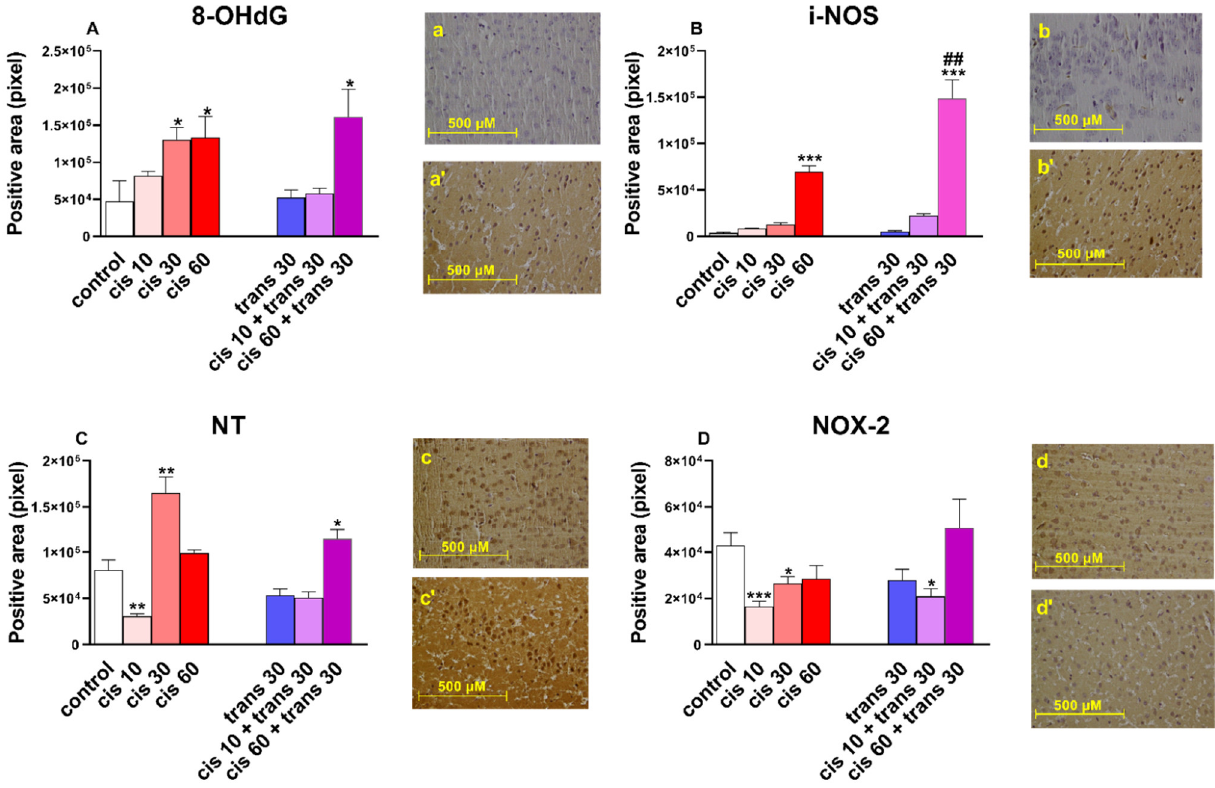
Figure 3. ( A ) Quantification and comparison of 8-OHdG positive areas in controls versus 4-4′-DMAR-mice ((±) cis 10, (±) cis 30, (±) cis 60, (±) trans 30, (±) trans 30 + (±) cis 10, (±) trans 30 + (±) cis 60). Representative image (light microscopy, 40×) of 8-OHdG immunostaining (brown areas) in the cortex of mice receiving 4-4′-DMAR ((±) cis 30, a’) and controls (a). ( B ) Quantification and comparison of iNOS positive areas in controls versus 4-4′-DMAR-mice ((±) cis 10, (±) cis 30, (±) cis 60, (±) trans 30, (±) trans 30 + (±) cis 10, (±) trans 30 + (±) cis 60). Comparison of (±) cis 60 versus (±) trans 30 + (±) cis 60. Representative image (light microscopy, 40×) of iNOS immunostaining (brown areas) in the cortex of mice receiving 4-4′-DMAR ((±) cis 60, b’) and controls (b). ( C ) Quantification and comparison of NT (nitrotyrosine) positive areas in controls versus 4-4′-DMAR-mice ((±) cis 10, (±) cis 30, (±) cis 60, (±) trans 30, (±) trans 30 + (±) cis 10, (±) trans 30 + (±) cis 60). Representative image (light microscopy, 40x) of NT immunostaining (brown areas) in the cortex of mice receiving 4-4′-DMAR ((±) cis 30, c’) and controls (c). ( D ) Quantification and comparison of NOX2 positive areas in controls versus 4-4′-DMAR-mice ((±) cis 10, (±) cis 30, (±) cis 60, (±) trans 30, (±) trans 30 + (±) cis 10, (±) trans 30 + (±) cis 60). Representative image (light microscopy, 40×) of NOX2 immunostaining (brown areas) in the cortex of mice receiving 4-4′-DMAR ((±) cis 30, d’) and controls (d). * p < 0.05, ** p < 0.01 and *** p < 0.001 different from control; ## p < 0.001 different from (±) cis 60.